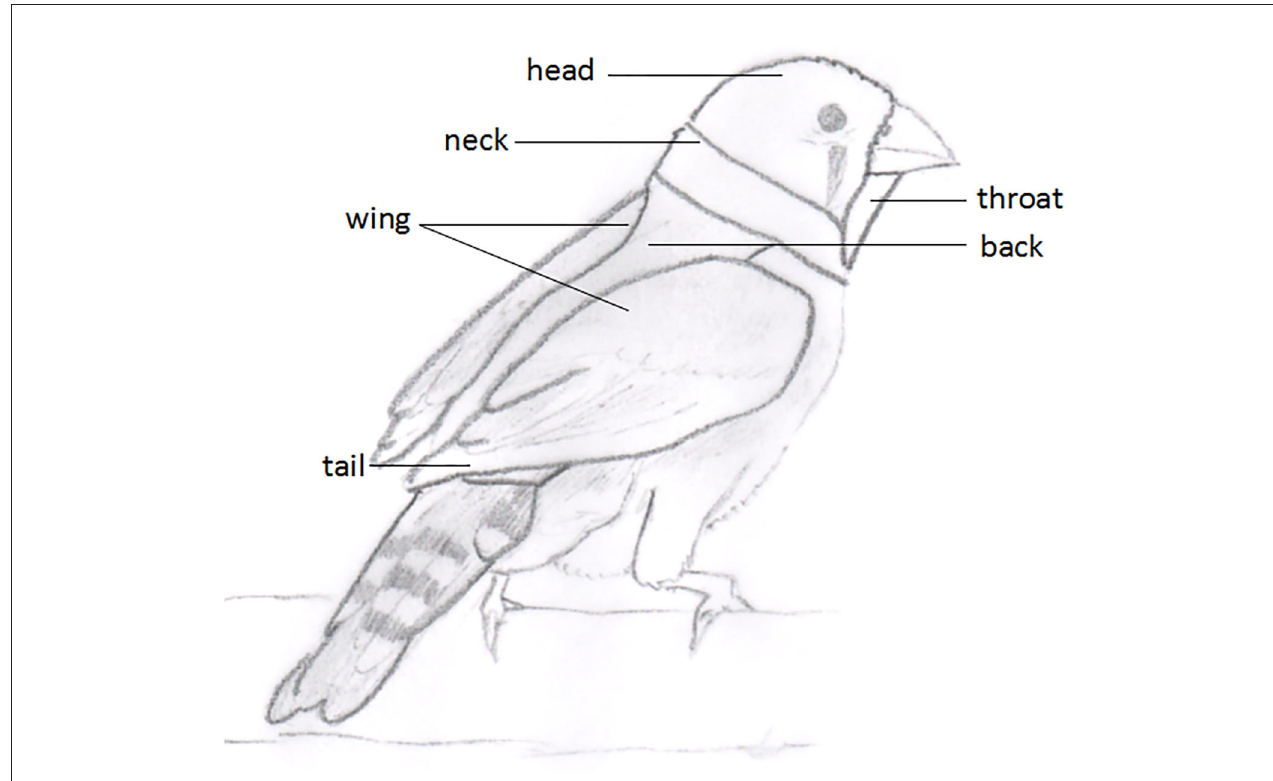
FIGURE 1 | Schematic overview of the six plumage parts of the Zebra Finches that were considered in the plumage scoring